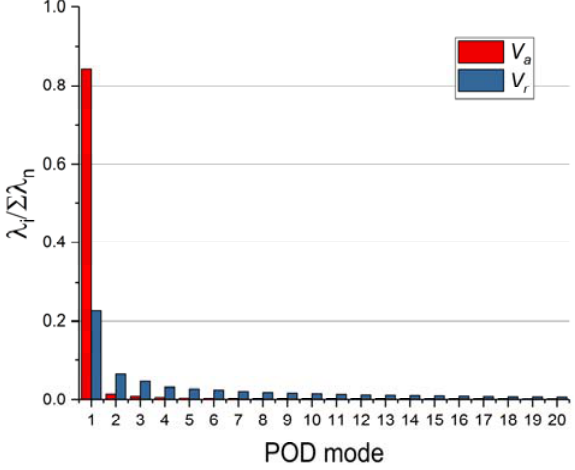
Figure 10. Normalized POD eigenvalues of MP7 in Case 1.